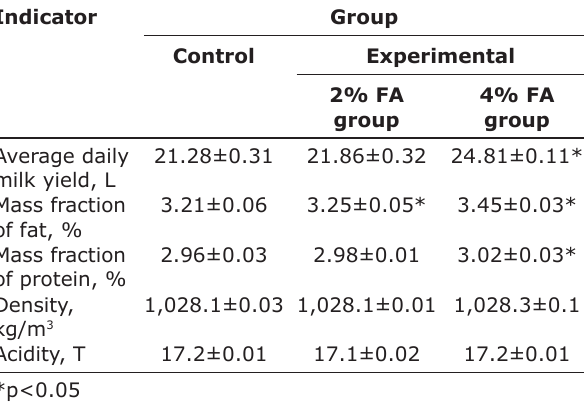
Table-4: Indicators of milk productivity and physicochemical properties of milk at the end of the experiment